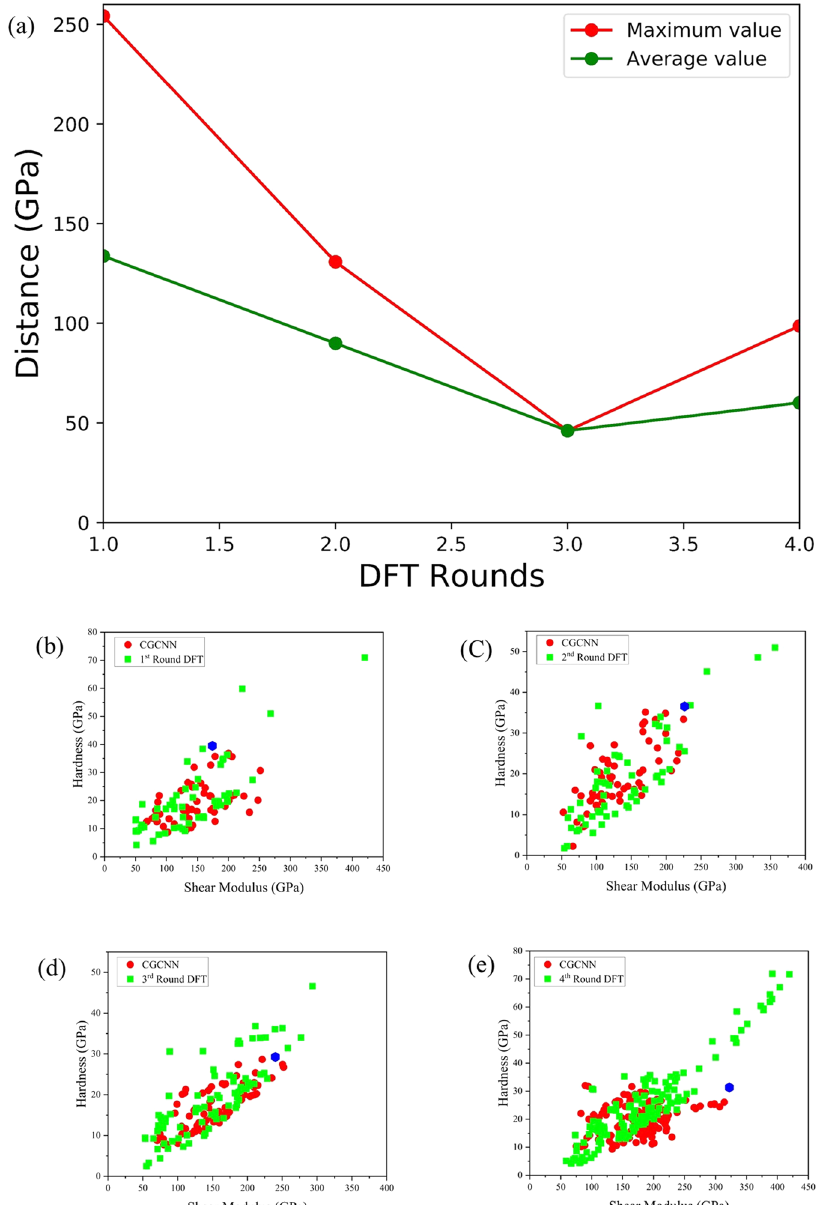
Fig. 6 Evaluation of prediction of CGCNN model for hardness vs. shear modulus. a Maximum and average distance between outlier of CGCNN prediction and DFT calculation for shear modulus and hardness. For each round we measure the distance between the outlier of CGCNN prediction (blue symbols in bottom panels) and all DFT values with shear modulus and hardness higher than CGCNN prediction. b – e Comparison between CGCNN prediction and DFT values for the 1st, 2nd, 3rd, and 4th round, respectively. The blue symbol denotes the outlier structure from CGCNN prediction that is used for calculating the distances to real DFT